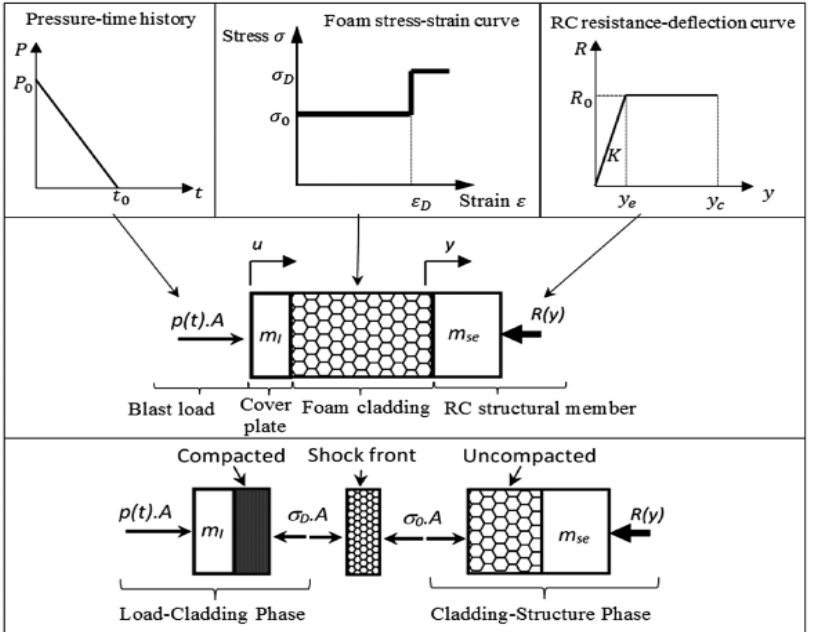
Fig. 12. LCS model For RC